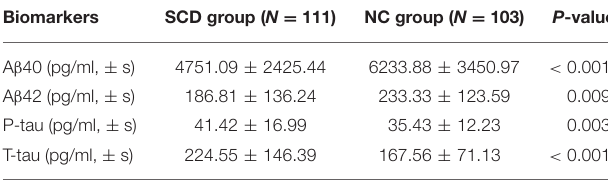
TABLE 2 | Comparison of CSF biomarker levels between the two